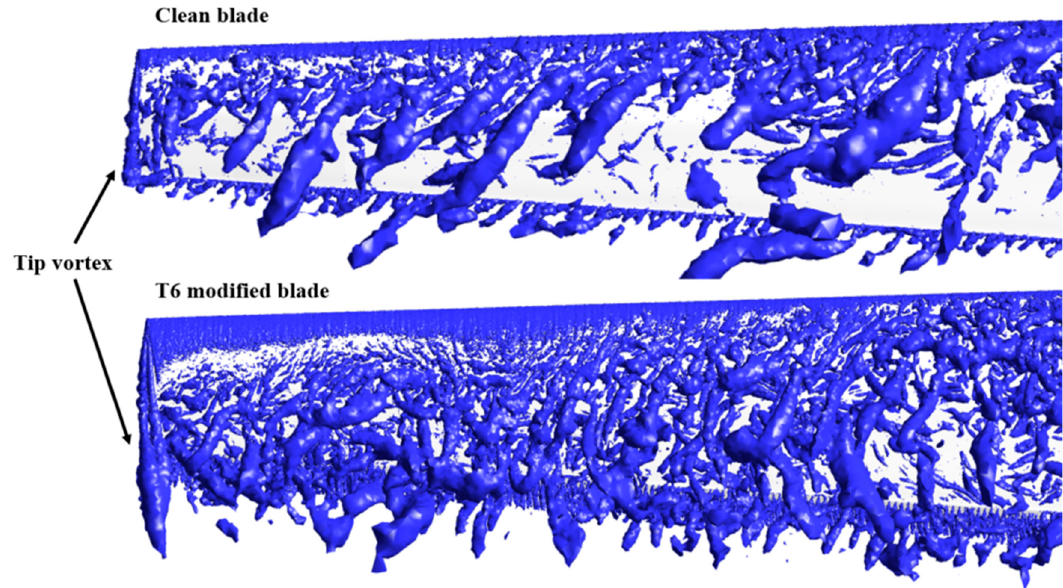
Figure 11. Instantaneous λ 2 criterion with level 0.03 at the time of 8.28 s for the clean blade and modified blade with configuration T6 at wind speed V = 10 m/s.